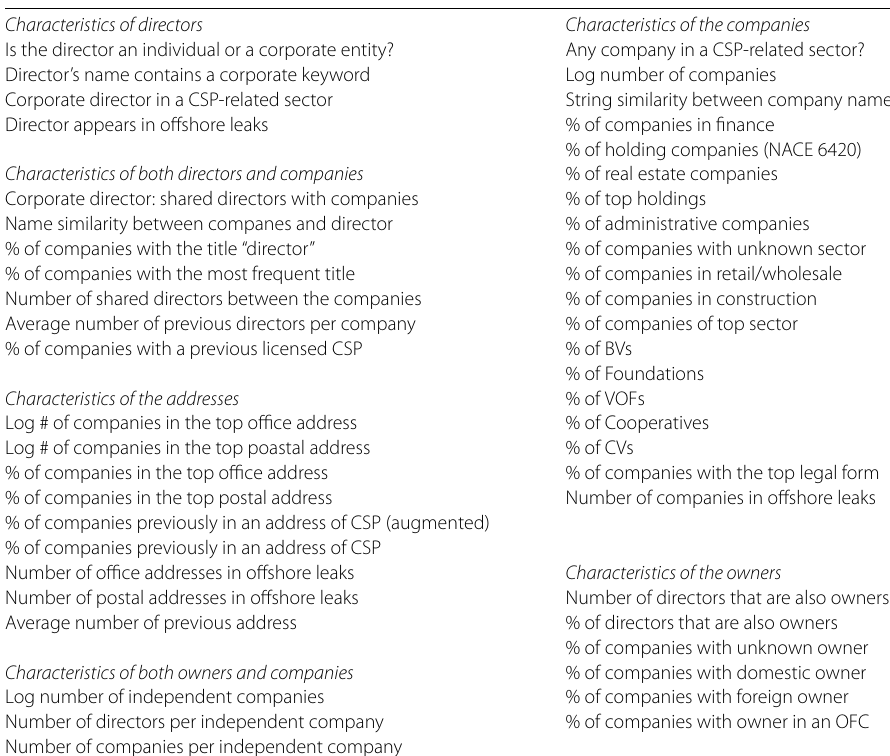
Table 1 Features constructed according to the category: features related to characteristics of the director, of the addresses, of the companies, of the owners, or of combinations. A full description of each variable can be found in Appendix